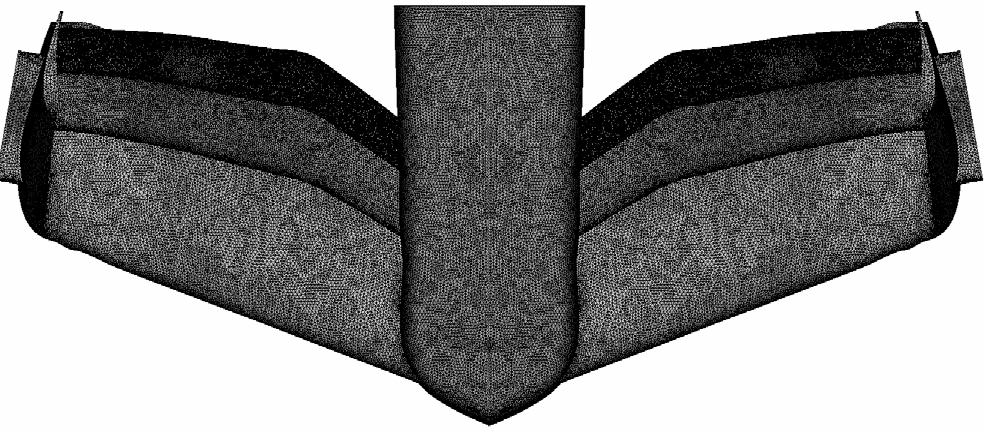
Figure 4. Mesh of the 2022 Formula One front wing assembly.